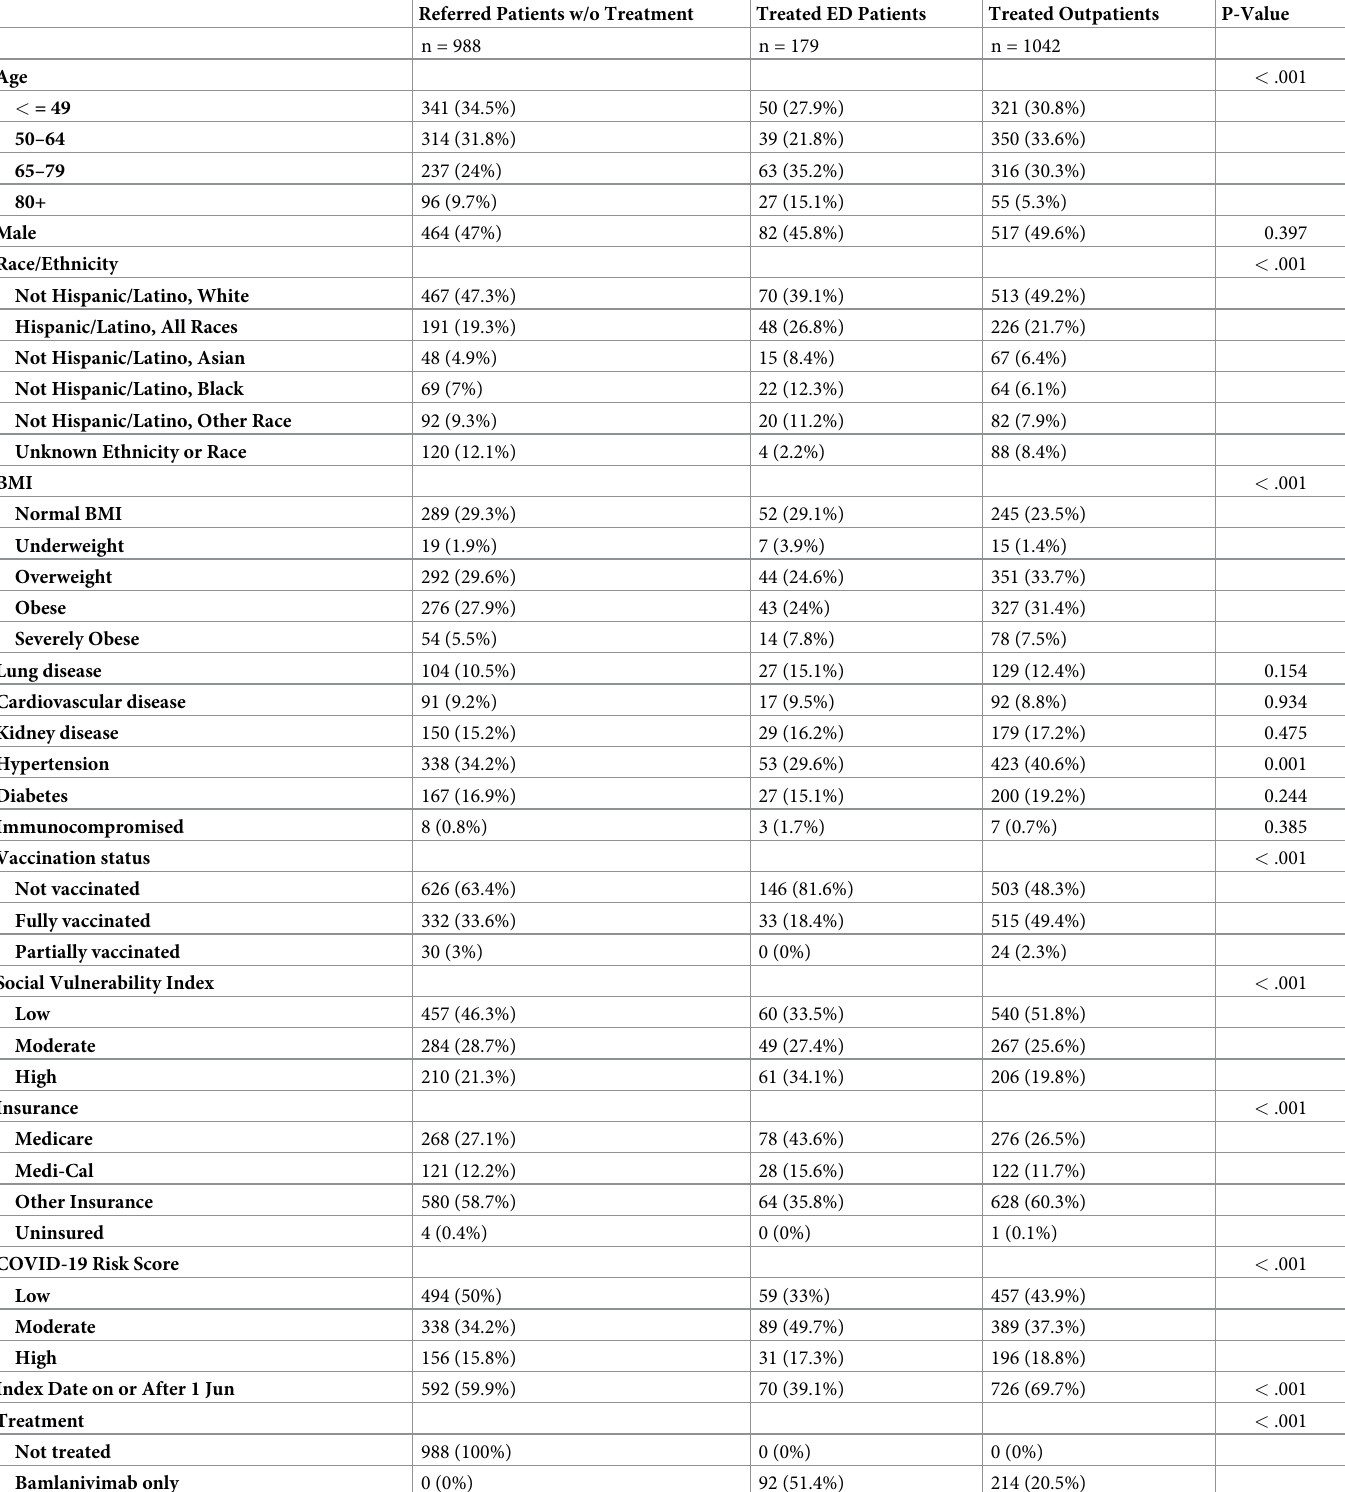
Table 1. Demographic characteristics of included patients grouped by location of treatment. Differences between groups assessed with t-tests or chi-square tests where